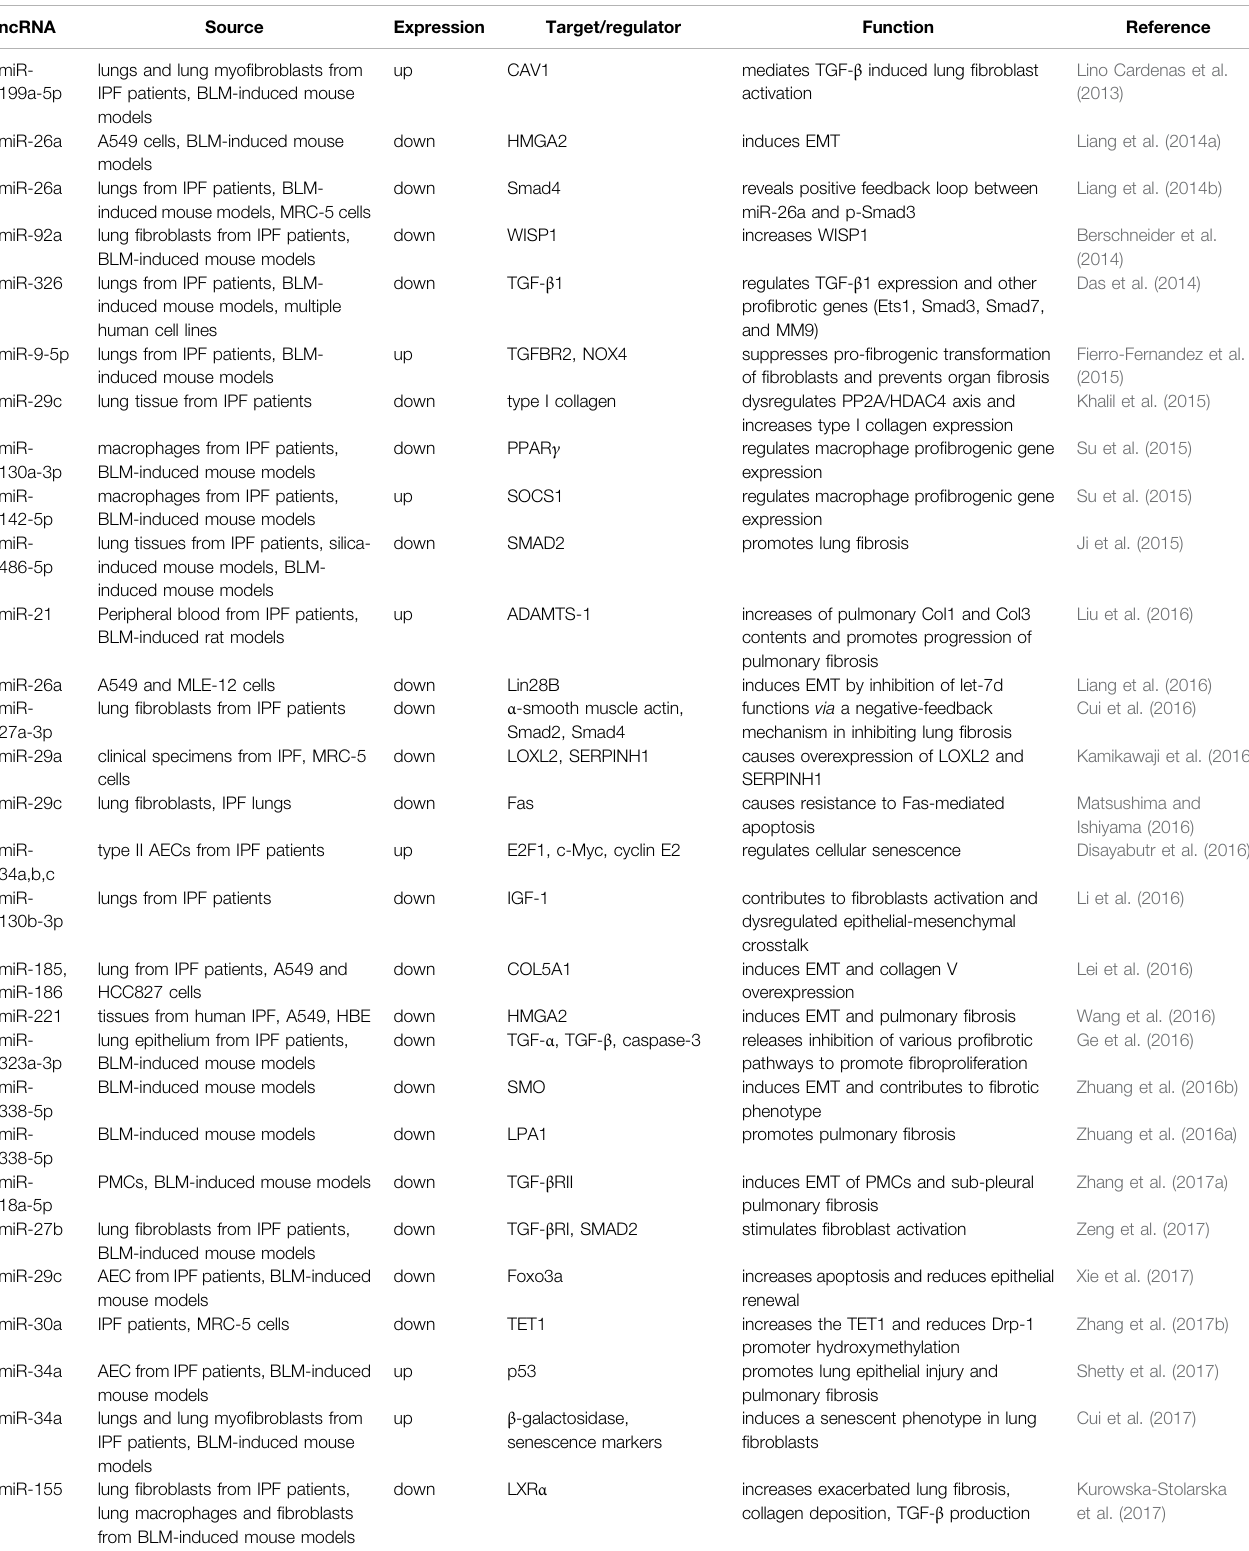
TABLE 5 | List of ncRNAs and their targets and functions in